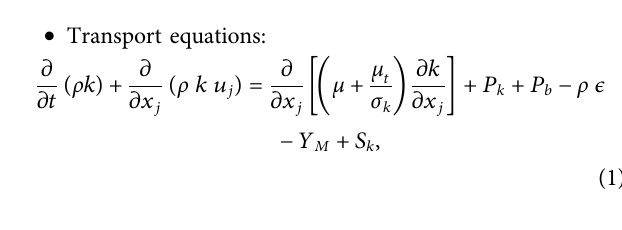
Frontiers in Energy Research |